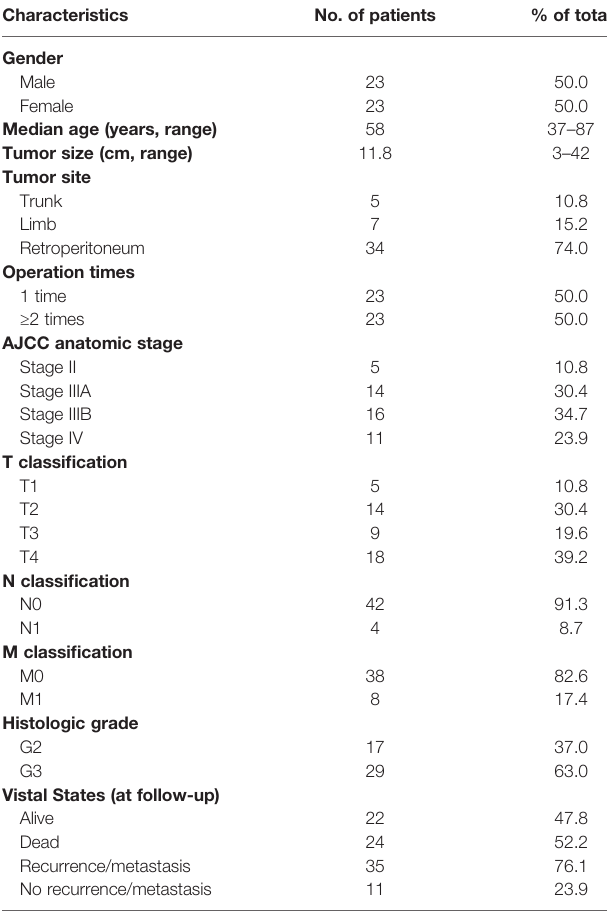
TABLE 1 | Baseline characteristics of the Patients (N =